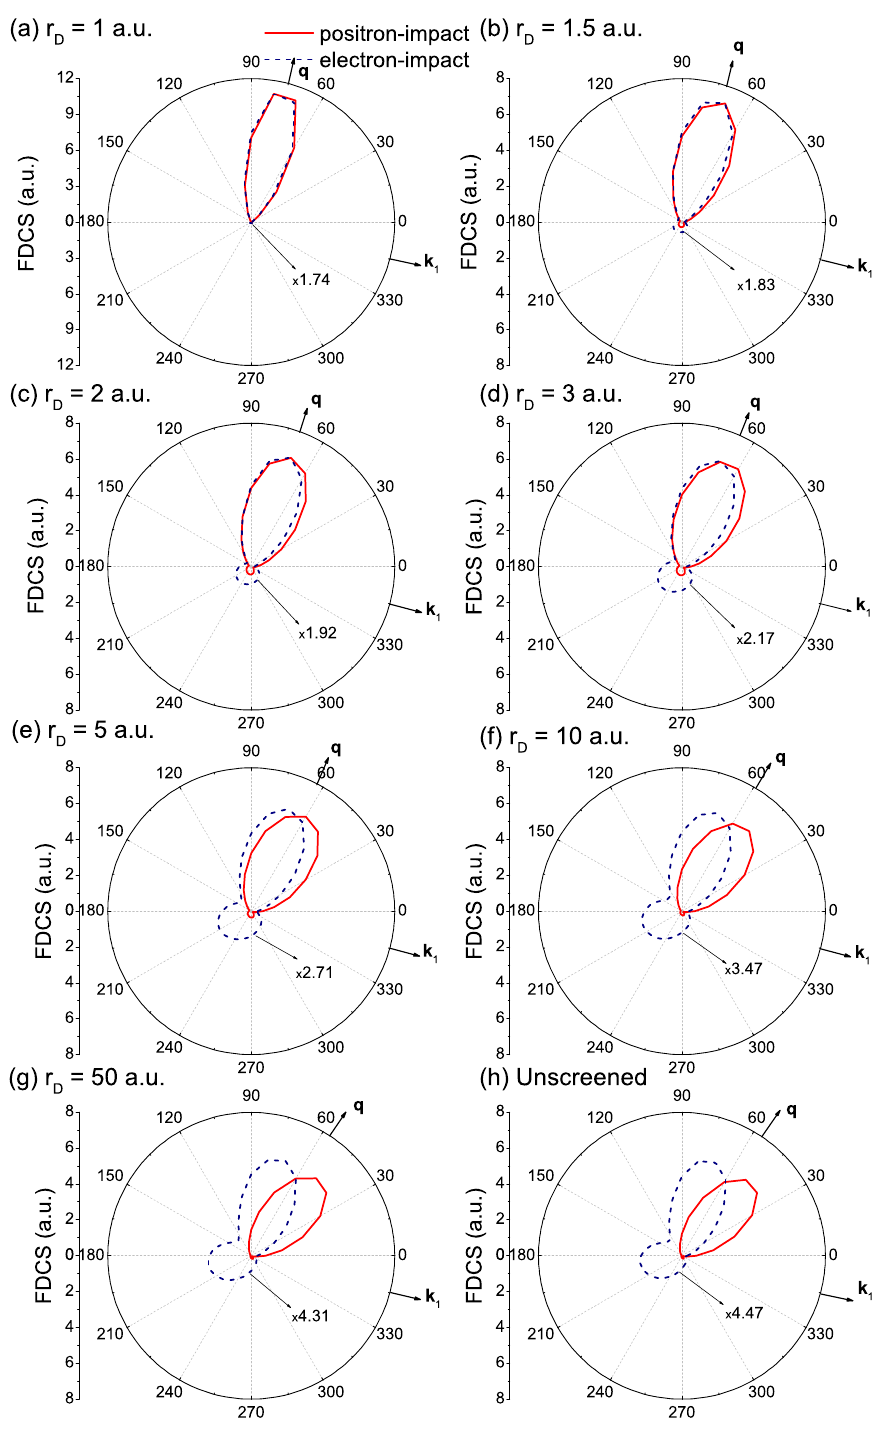
Figure 6. The same visualization as in Figure 4 but for θ 1 = − 15 ◦